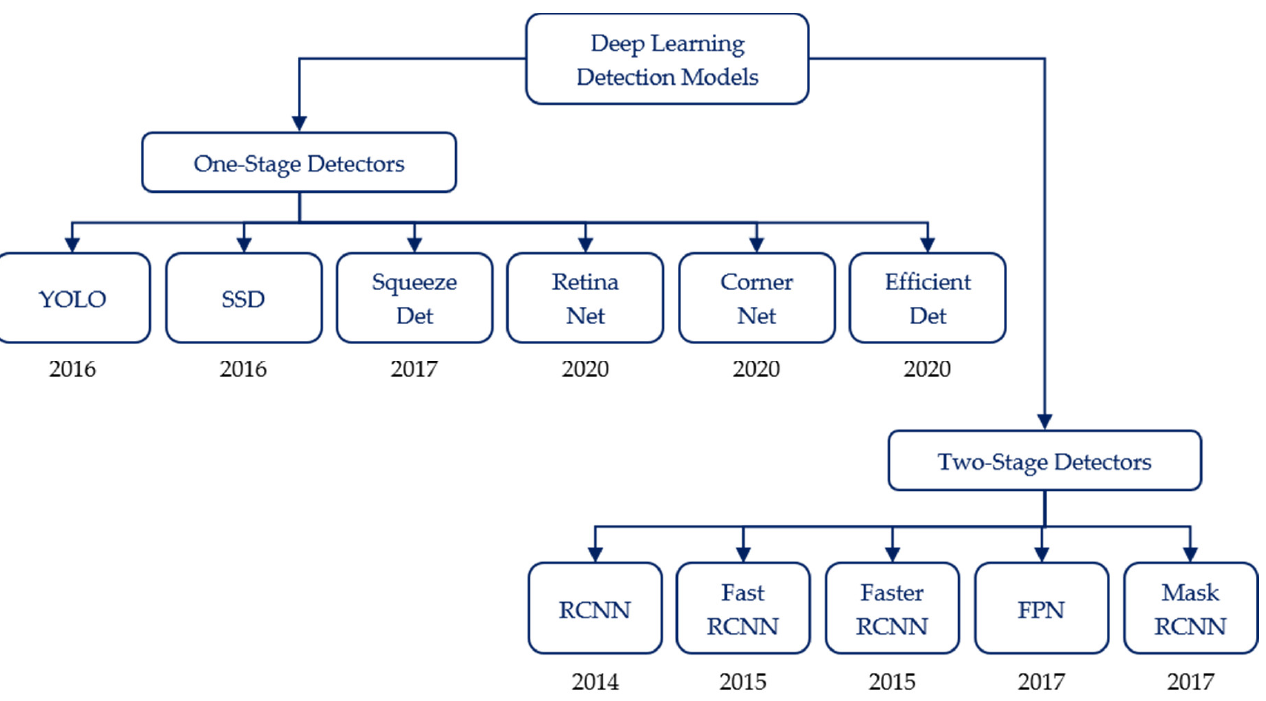
Figure 1. Development stages of deep learning object detection [31].